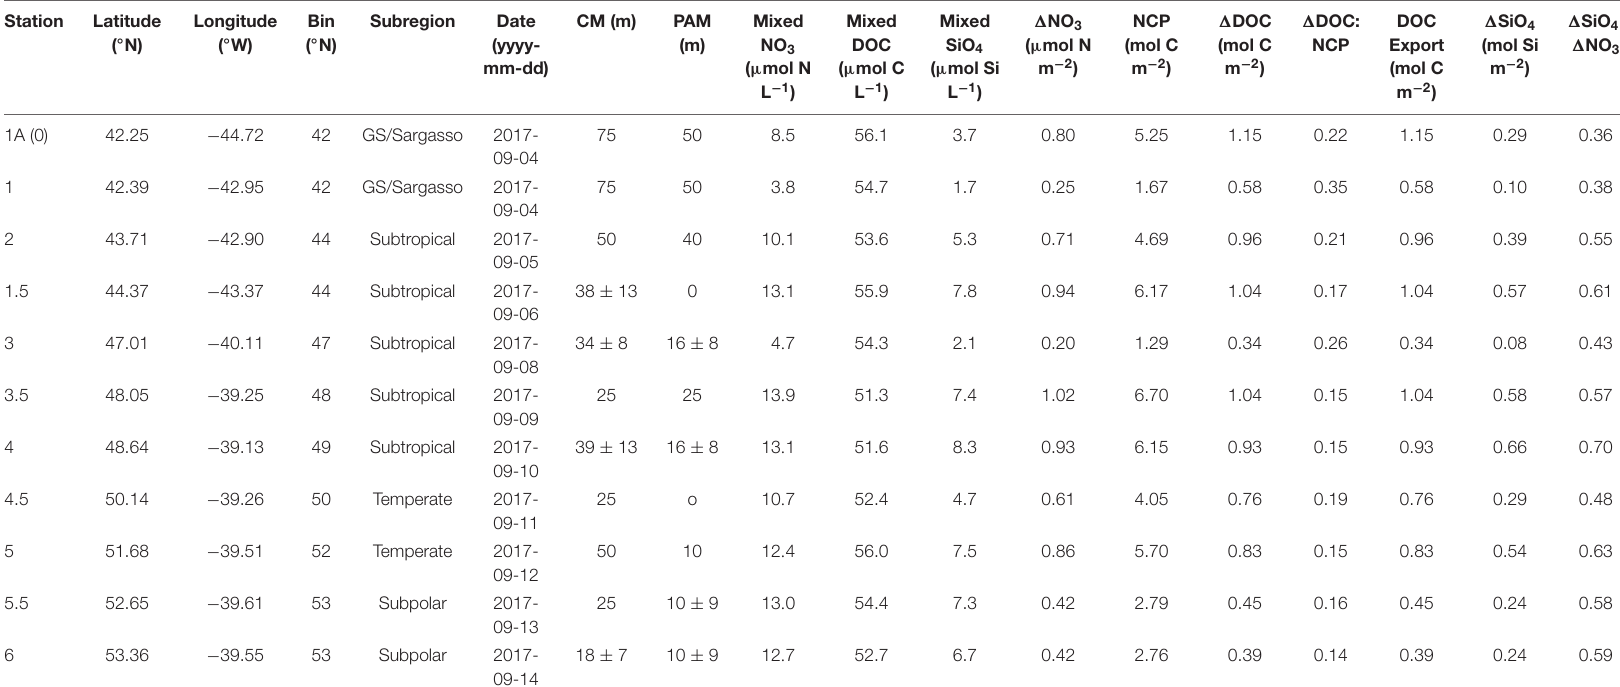
TABLE 2 | Seasonal net community production ( NCP ) and its partitioning into DOC in the upper 100 m as well as DOC export out of the upper 100 m for the early autumn campaign. CM refers to the chlorophyll maximum and PAM refers to the phytoplankton abundance maximum.